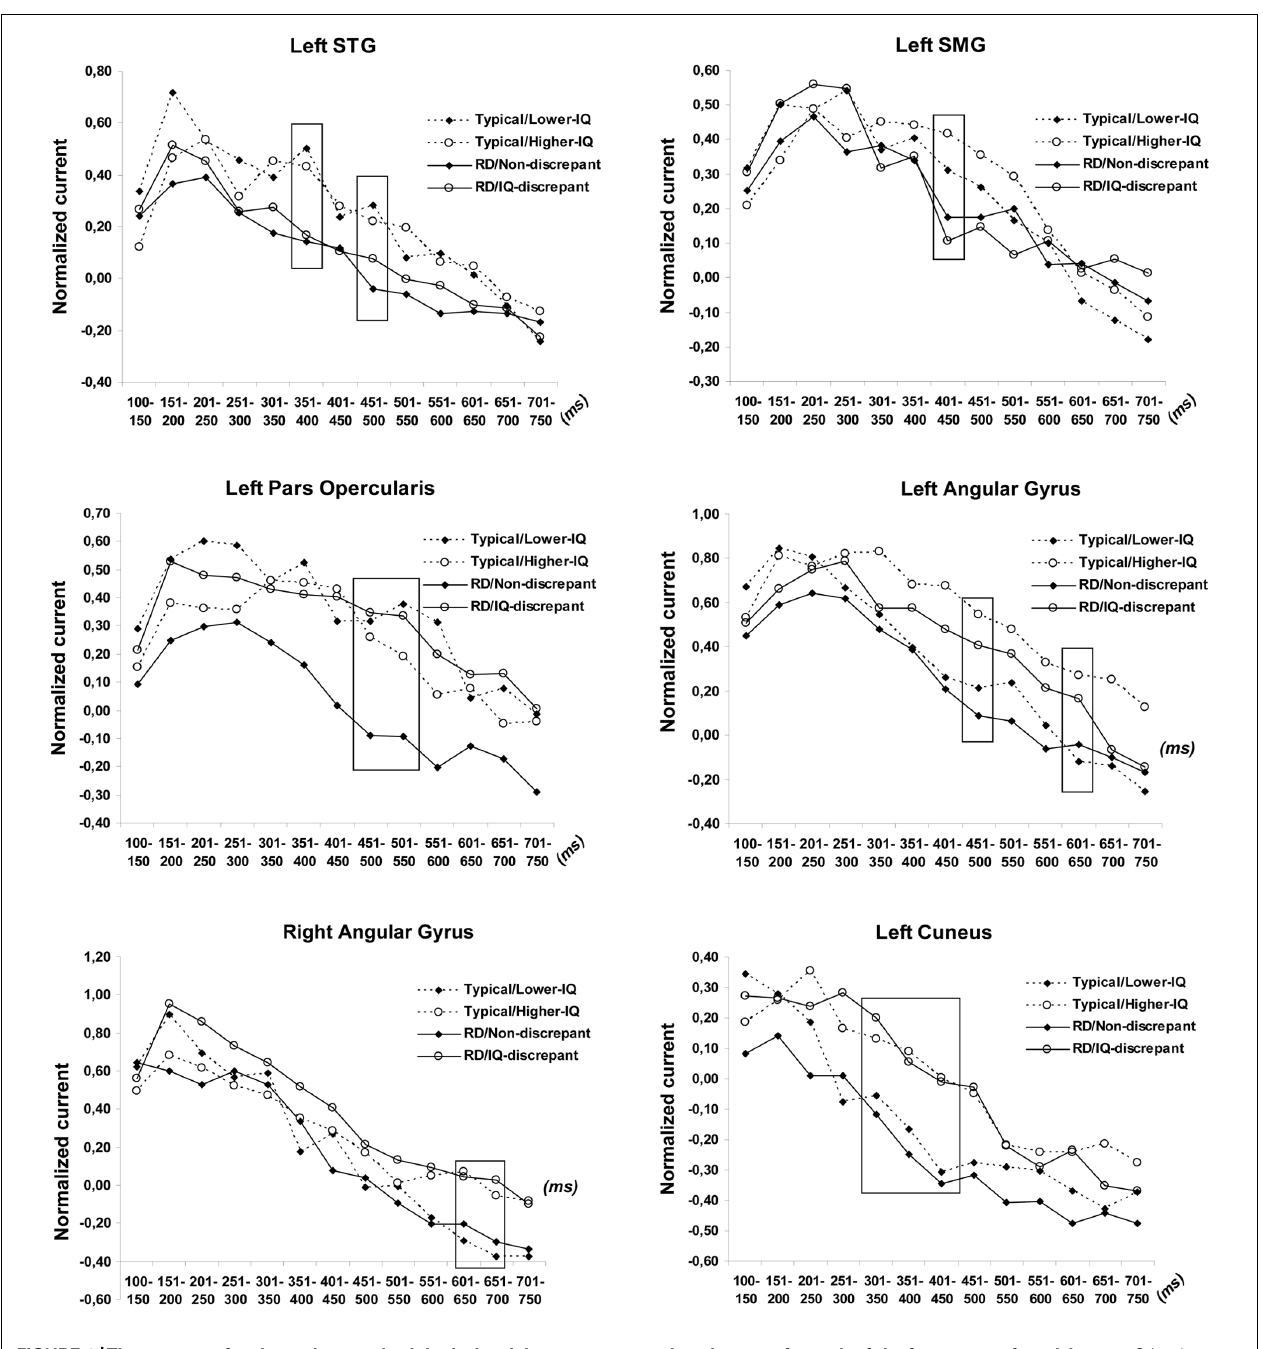
FIGURE 1 |Time course of estimated neurophysiological activity (nano-Amperes normalized to baseline) associated with pseudoword reading in the superior temporal (STG), supramarginal (SMG), angular